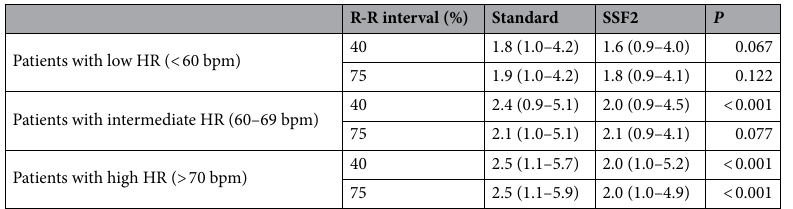
Table 3. Comparison of the edge rise distance (mm) on scans subjected to standard- and SSF2 reconstruction. HR Heart rate. Values are the median (range).